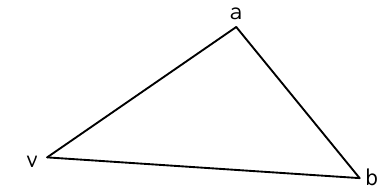
Figure 3: A triangle and a